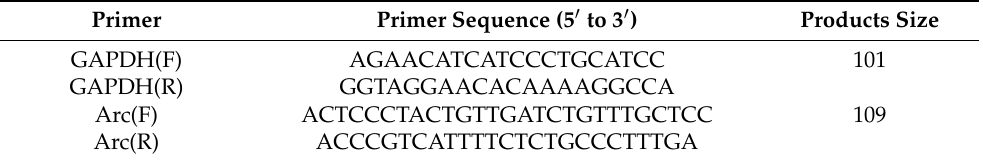
Table 1. Primer sequence and amplification length of destination fragment.